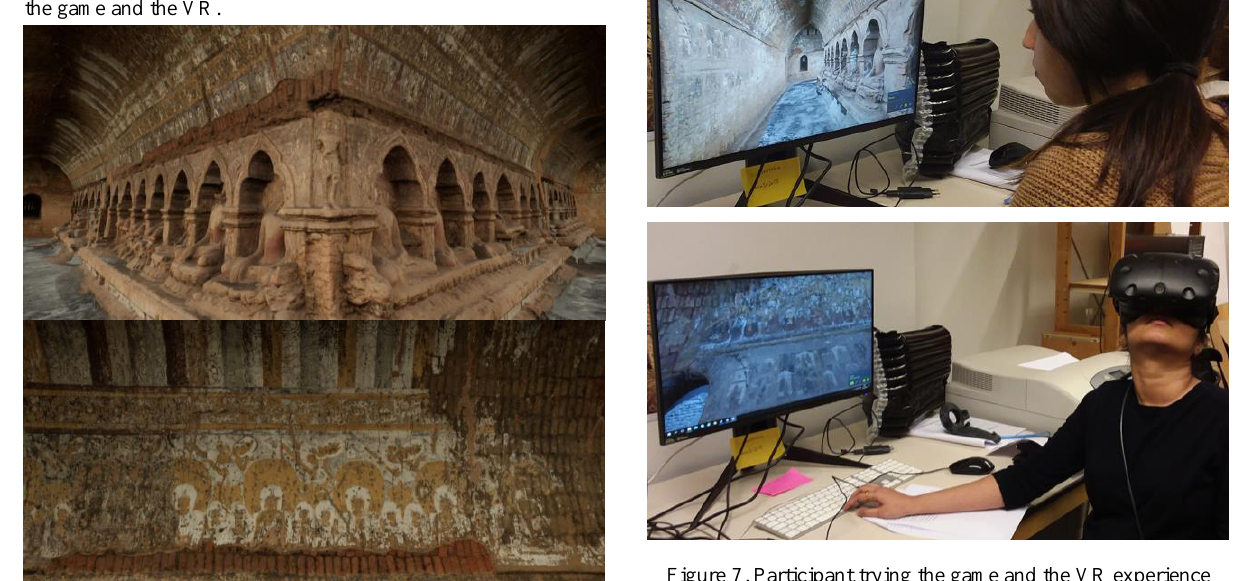
Figure 7. Participant trying the game and the VR Figure 6. Screenshots from the Virtual experience: walls and ceiling